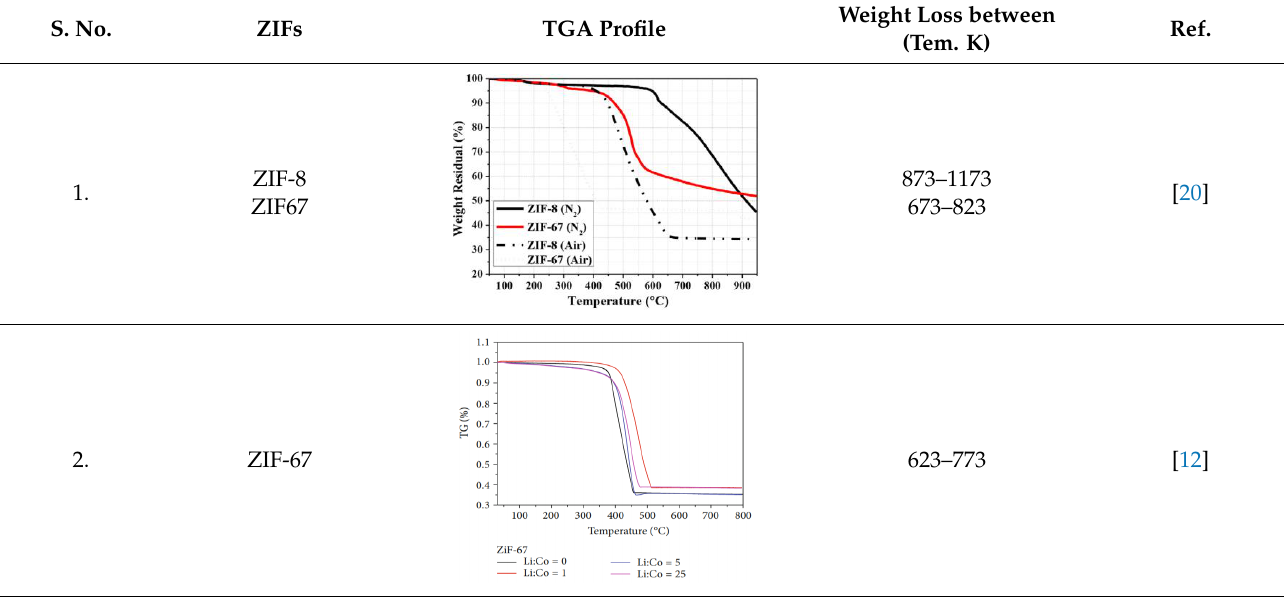
Table 5. ZIFs and their observations after TGA.